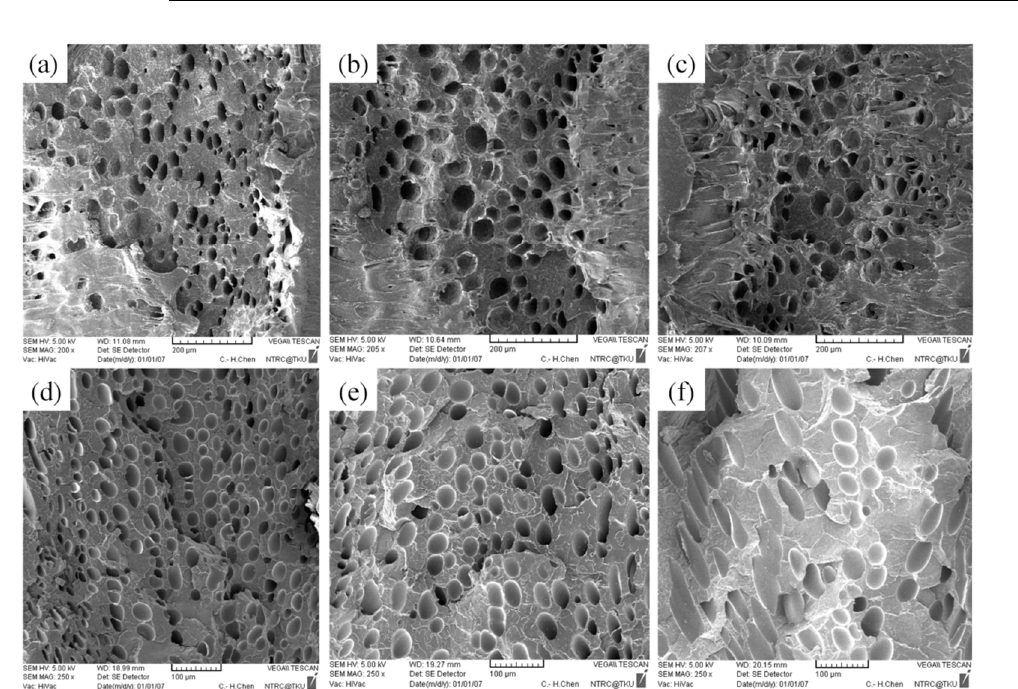
Figure 14. SEM micrographs of PP for different mold temperatures: ( a ) 50 °C, ( b ) 60 °C, ( c ) 70 °C; SEM micrographs of PS for different mold temperatures: ( d ) 50 °C, ( e ) 60 °C, ( f ) 70 °C.